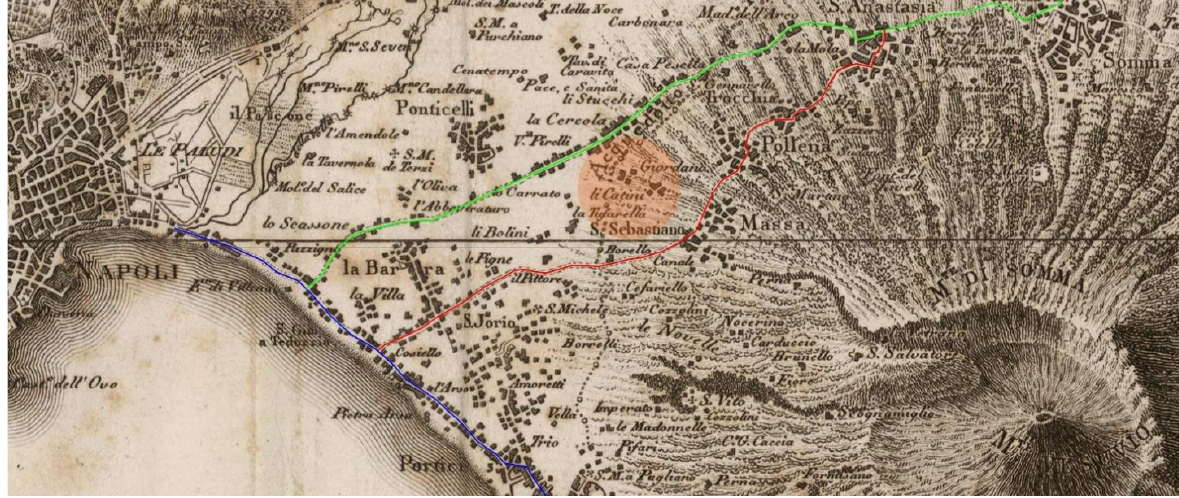
Figure 2. Atlante geografico del Regno di Napoli delineato per ordine di Ferdinando IV re delle Due Sicilie & C. & C. da